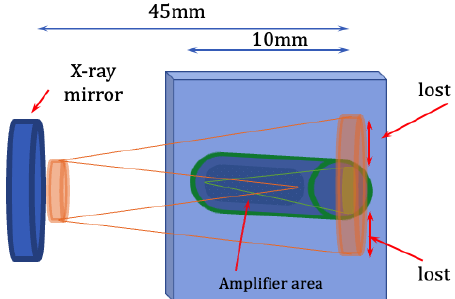
Figure 4. Schematic of the explanation of the coupling coefficient. The geometory of the target and X-ray mirror is also shown.